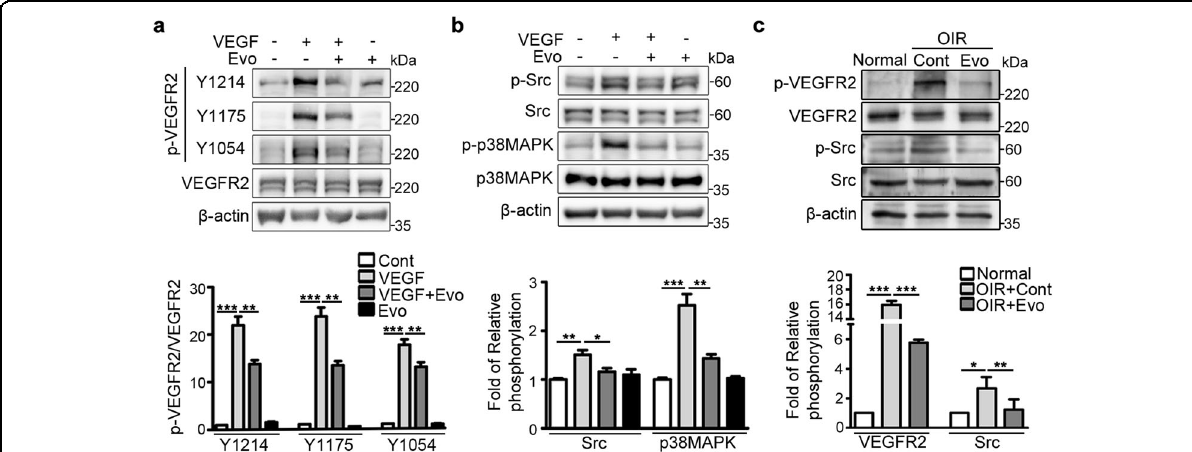
Fig. 3 Evogliptin inhibited the VEGF-mediated angiogenic signaling pathway in endothelial cells. a , b Representative western blotting images and densitometric analysis of phosphorylated a VEGFR2 (p-VEGFR2) and b downstream signaling molecules (p-Src and p-p38 MAPK) in HUVECs. Cells were treated with or without evogliptin (Evo) and VEGF for 15 min, and cell lysates were subjected to western blotting. Band intensities of phosphorylated proteins were normalized to those of the total proteins (three independent experiments). c Representative western blotting images and densitometric analysis of p-VEGFR2 and p-Src levels in the retinal tissues of normal mice and mice with OIR. On P12, mice with OIR received a single intravitreal injection of Evo or DMSO (Cont). On P13, the retinal tissues of normal mice and mice with OIR were harvested for western blotting ( n = 3 mice). All data are presented as the mean ± SEM (one-way ANOVA with Bonferroni post hoc multiple comparison test, * p < 0.05, ** p < 0.01, *** p <